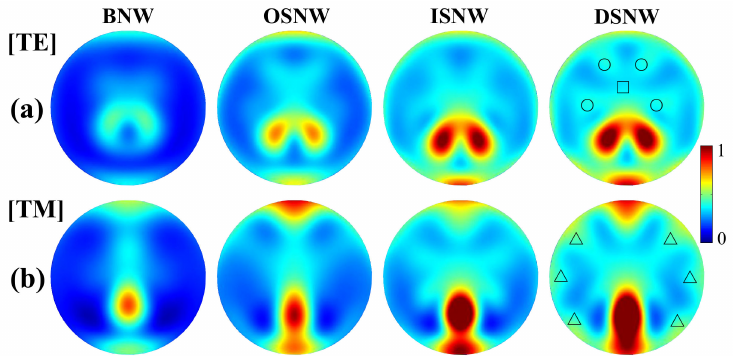
Figure 4. The normalized generation rate profiles of the DSNW for ( a ) TE and ( b ) TM light, together with the BNW, OSNW and ISNW for comparison. Note that the regions labeled by circles and triangles denote that the absorption of the DSNW is significantly enhanced for TE and TM light and the region labeled by the square denotes that the absorption of the DSNW is slightly decreased for TE light,